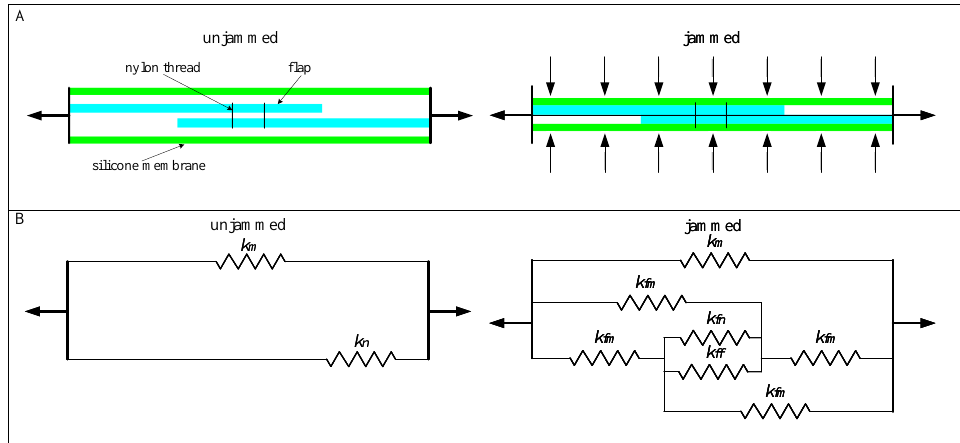
Figure 3. Schematic of analytical model of structural jamming. ( A ) Schematic showing the flap behavior in the unjammed and jammed cases. Only two layers are shown for simplicity. ( B ) Stiffness model of the unjammed and jammed cases of two-layer